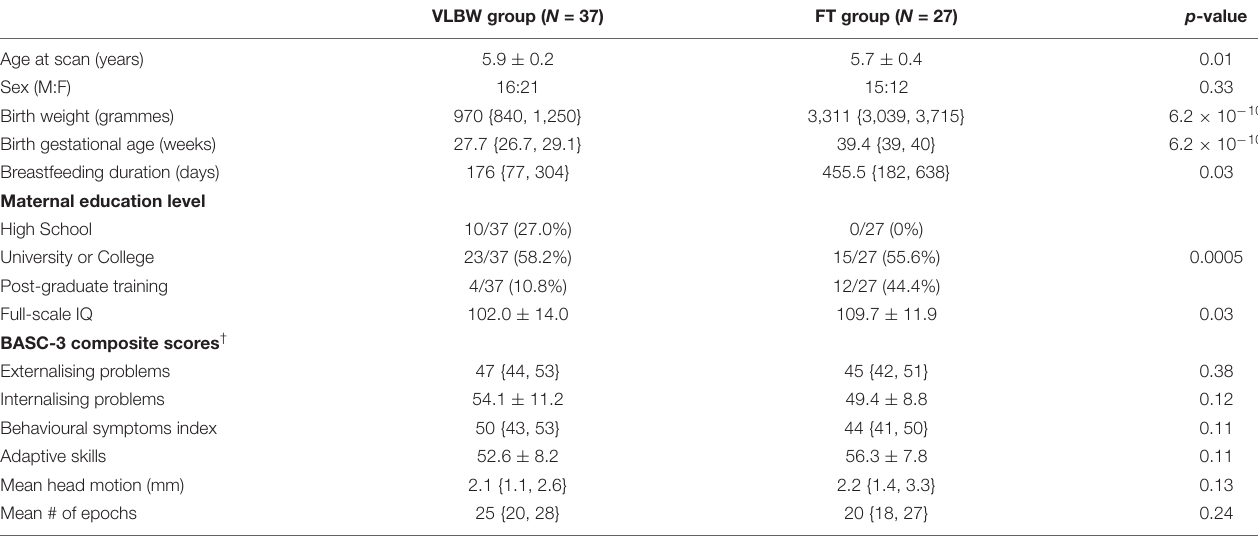
TABLE 1 | Demographic and neuropsychological measures in VLBW and FT children.